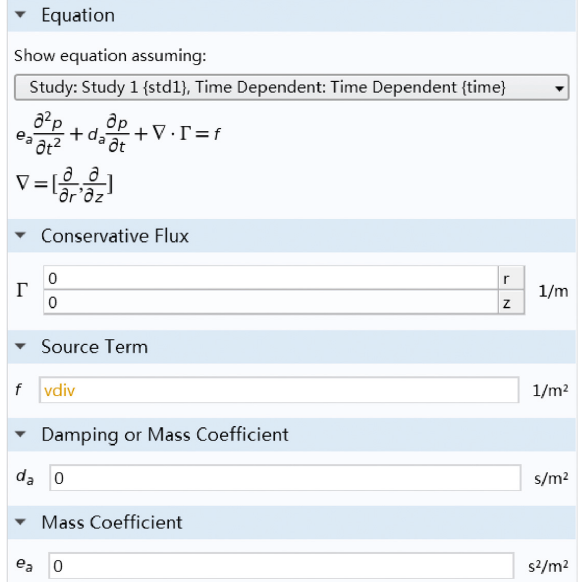
Figure 5: Input of mass conservation equation in